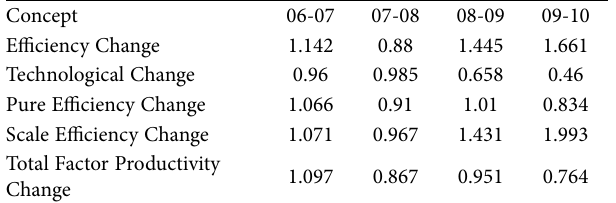
Table 2. Summary of the Malmquist Productivity Index for the (2006 to 2010).